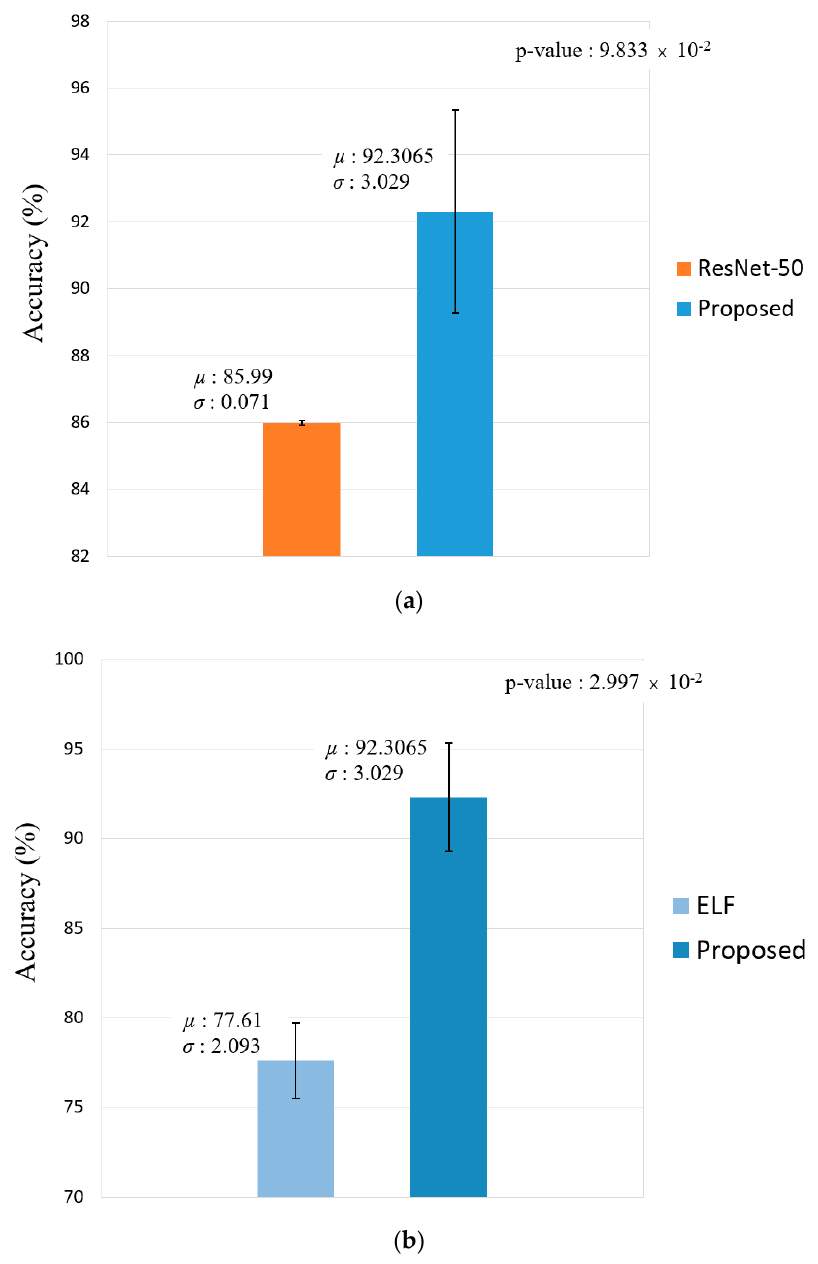
Figure 11. T-test performance of our proposed method and the second-best model in terms of average accuracy. ( a ) Comparison of the proposed method and ResNet-50 and ( b ) comparison of the proposed method and ensemble of localized features (ELF).